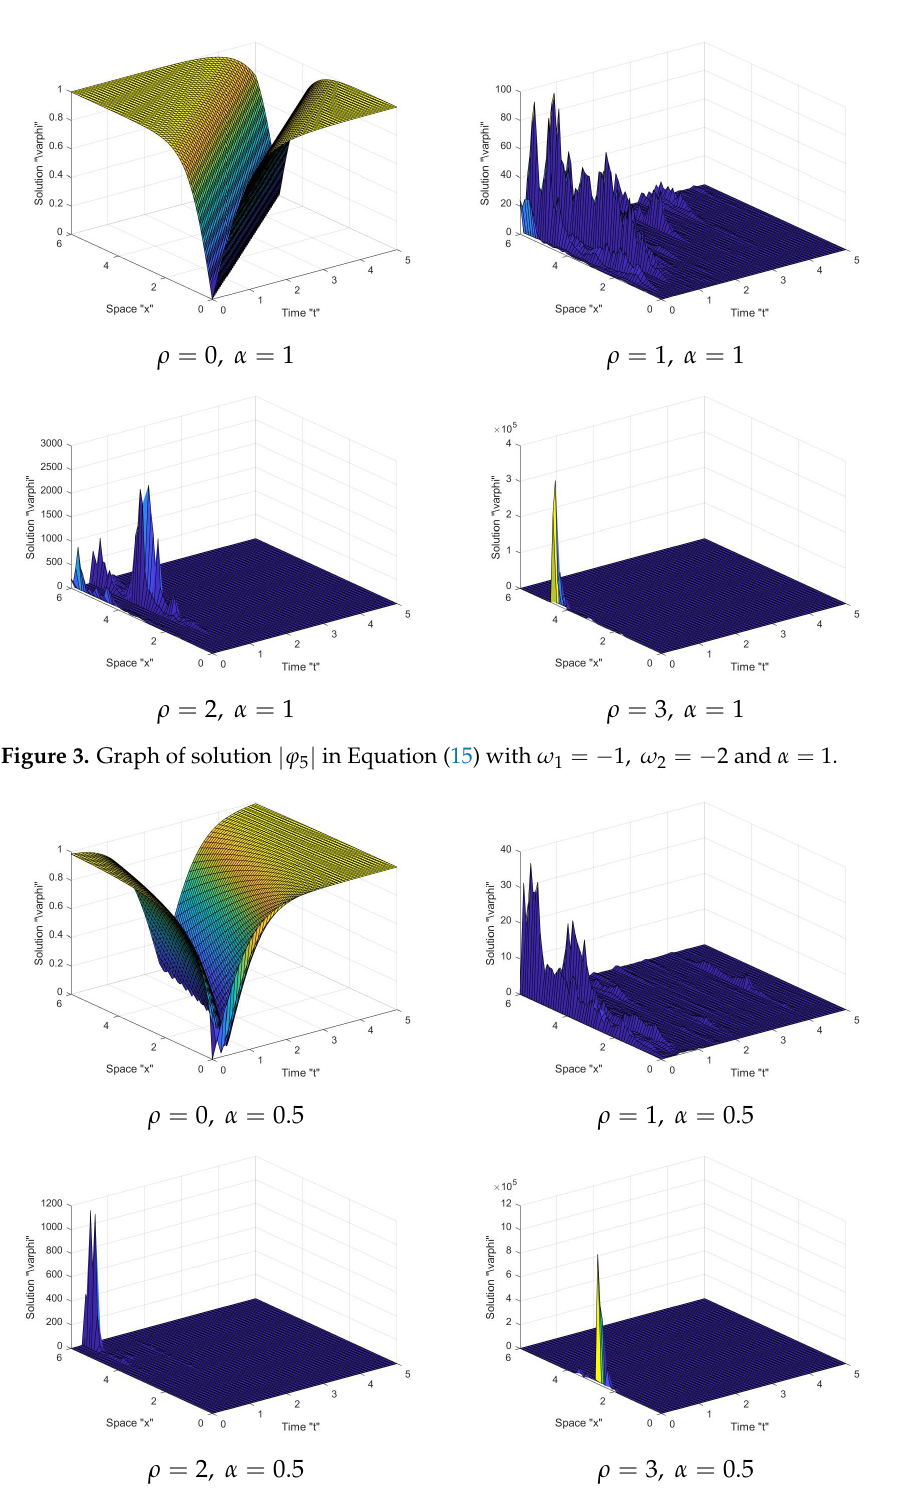
Figure 4. Graph of solution | ϕ 5 | in Equation (13) with ω 1 = − 1, ω 2 = − 2 and α =